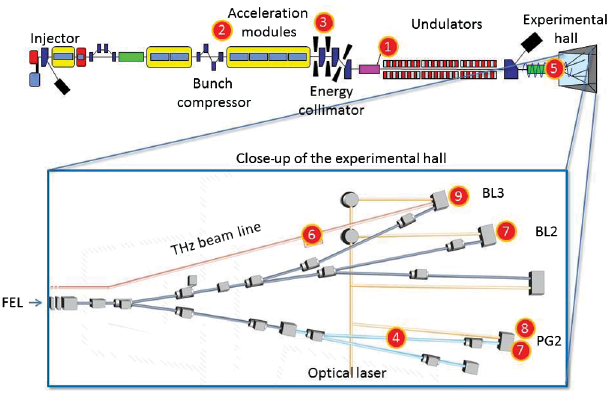
FIG. 1. Schematic layout of the FLASH accelerator and the experimental hall (not to scale). The total length of the facility is 315 m. The positions of the various techniques for electron bunch or photon pulse duration measurements are indicated by numbers: (1) Transverse deflecting rf structure, (2) bunch compression monitors, (3) terahertz spectrometer CRISP, (4) XUV spectra, (5) XUV statistics, (6) optical replica (afterburner), (7) XUV autocorrelation (gas phase), (8) XUVautocorrelation (solid state), and (9) terahertz streaking.